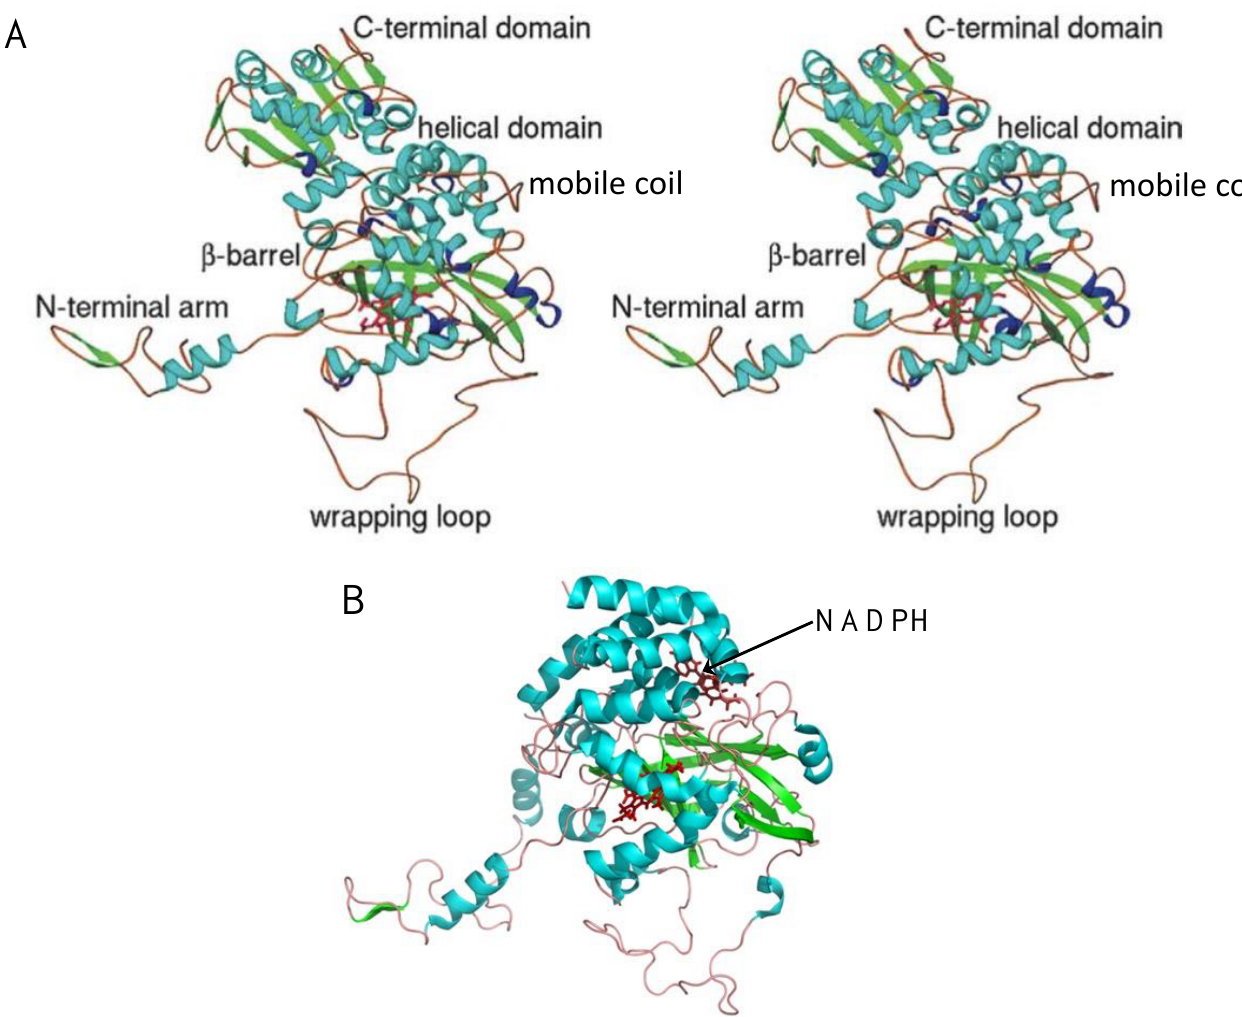
Figure 1. Structural regions in the monomer of CAT-1 and beef liver catalase (BLC). ( A ) Stereo view of a CAT-1 monomer with the heme in red, β -sheets in green, α -helices in blue, helices 3 10 in dark blue, and coils in orange. The view is from the Q axis and the P and R axes are in plane with the page. Reprinted with permission from Figure 2A in ref. [41] 2004, Elsevier ( B ) Monomer of BLC with similar colors and orientation to the CAT-1 monomer. Arrow indicates the bound NADPH.